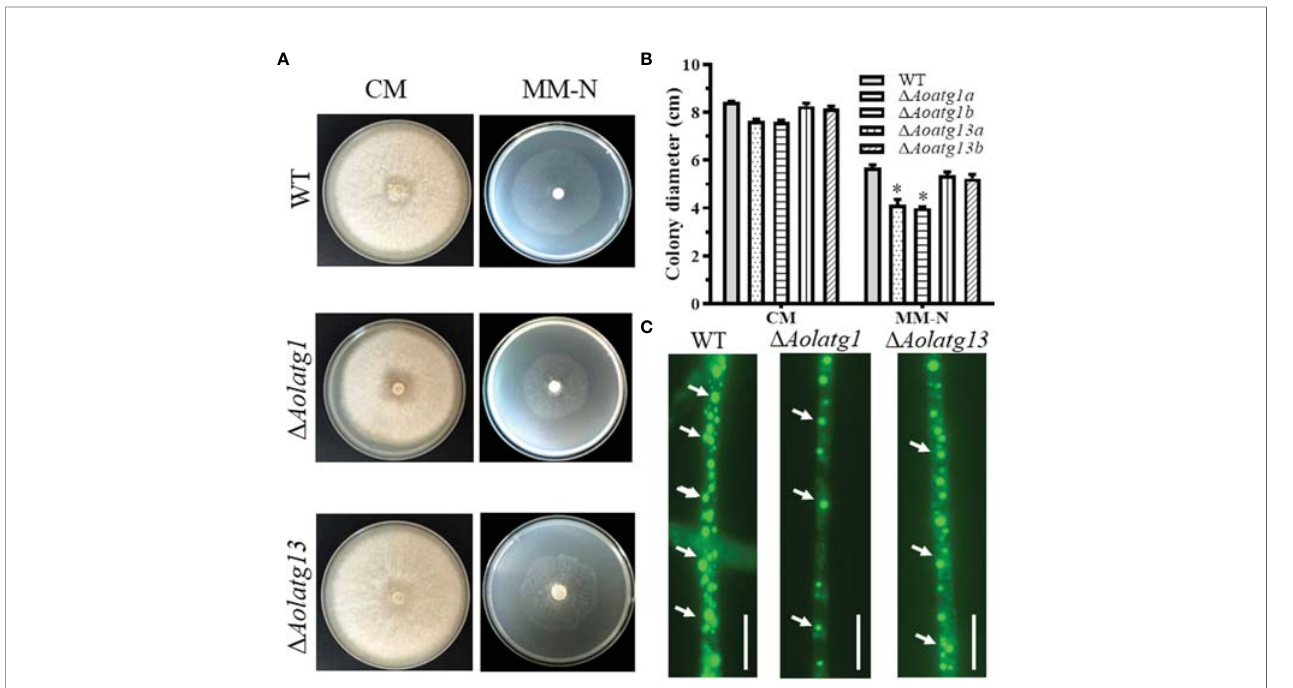
FIGURE 1 | Comparison of mycelial growth in the WT and mutant strains of Arthrobotrys oligospora on CM and MM-N plates. (A) Colony morphology of fungal strains incubated on CM and MM-N plates at 28°C for 6 days. (B) Colony diameters of fungal strains incubated on CM and MM-N plates at 28°C for 6 days. Data are presented as the mean ± standard deviation. Statistical signi fi cance of differences between mutant strains and WT strain is indicated as follows: * P < 0.05 (Tukey ’ s HSD). (C) Comparison of lipid droplets (LDs) in the WT and mutant strains. The arrows indicate LDs stained with BODIPY staining solution. Scale bars = 10